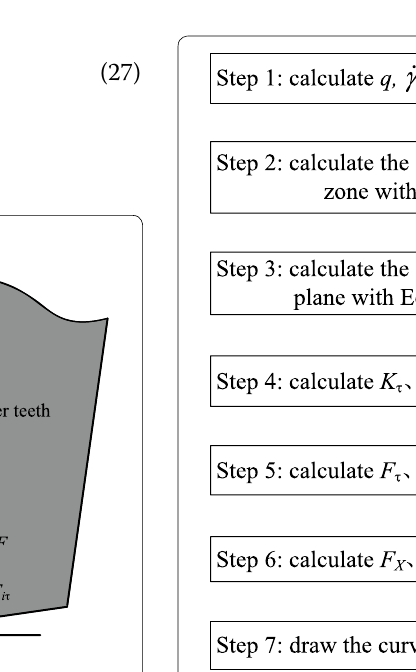
Figure 5 Resolution of cutting force Figure 6 Calculation process of milling sand